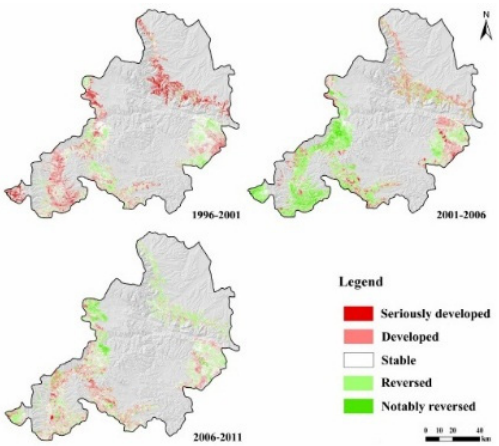
Figure 6. Rangeland degradation spatial dynamics for Linxia rangeland during 1996–2001, Figure 2001–2006, and 2006–2011. The base map was the hillshade result of digital elevation model (DEM) topographical analysis.